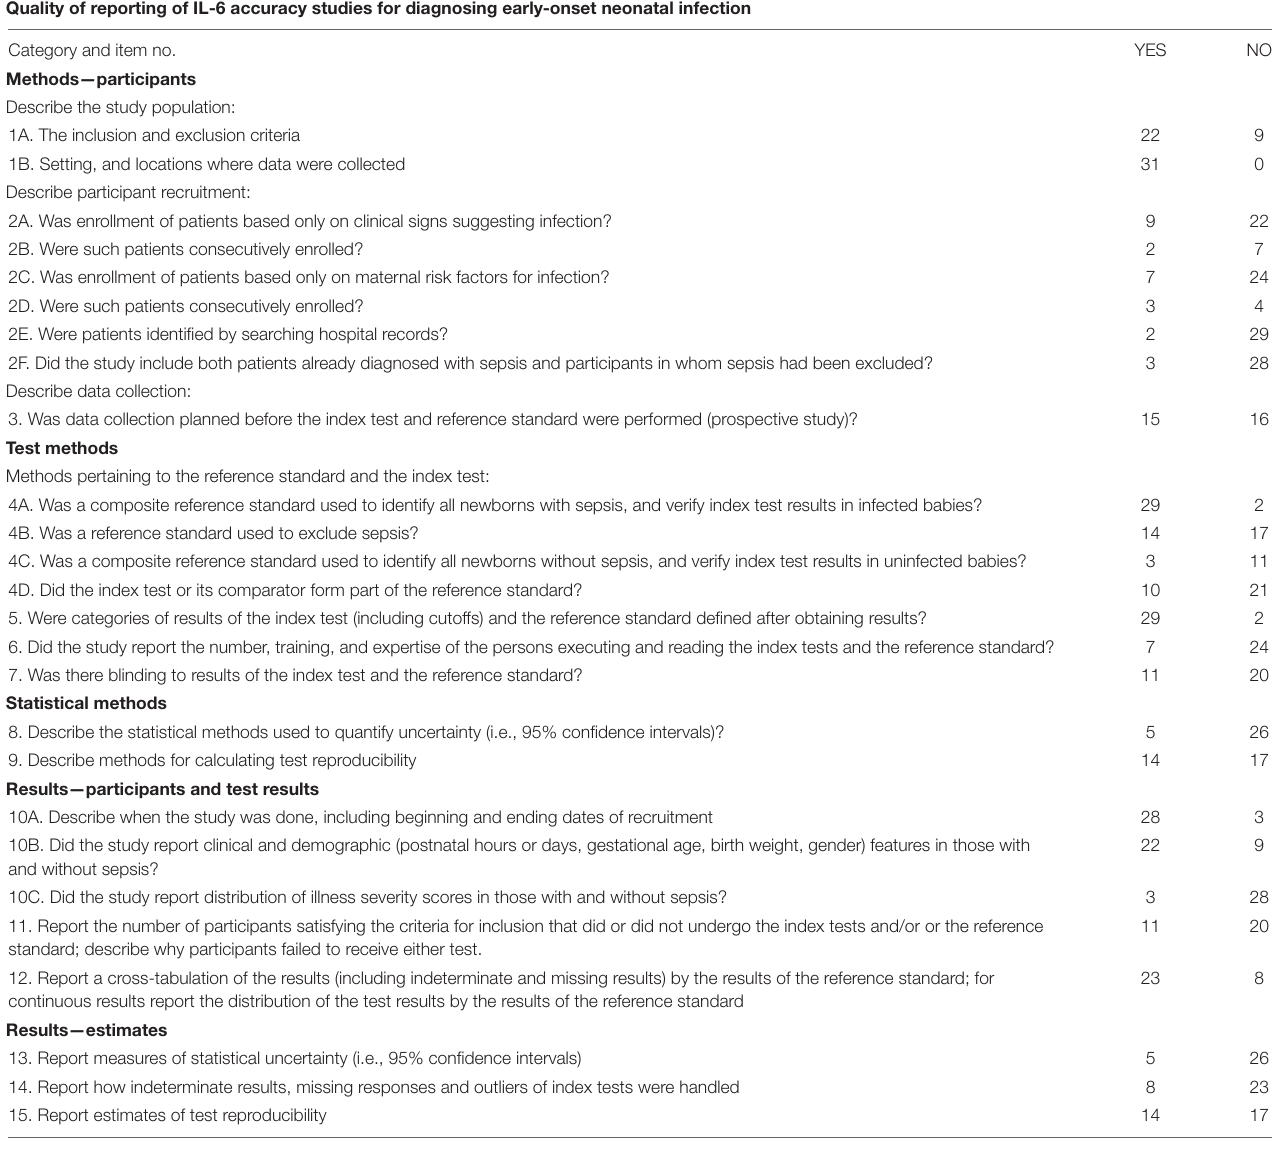
TABLE 5 | Quality of IL-6 accuracy studies for diagnosing early-onset neonatal sepsis from 1990 to 2020 according to the STARD criteria (Standards of Reporting Diagnostic Accuracy Studies). Quality of reporting of IL-6 accuracy studies for diagnosing early-onset neonatal infection Category and item